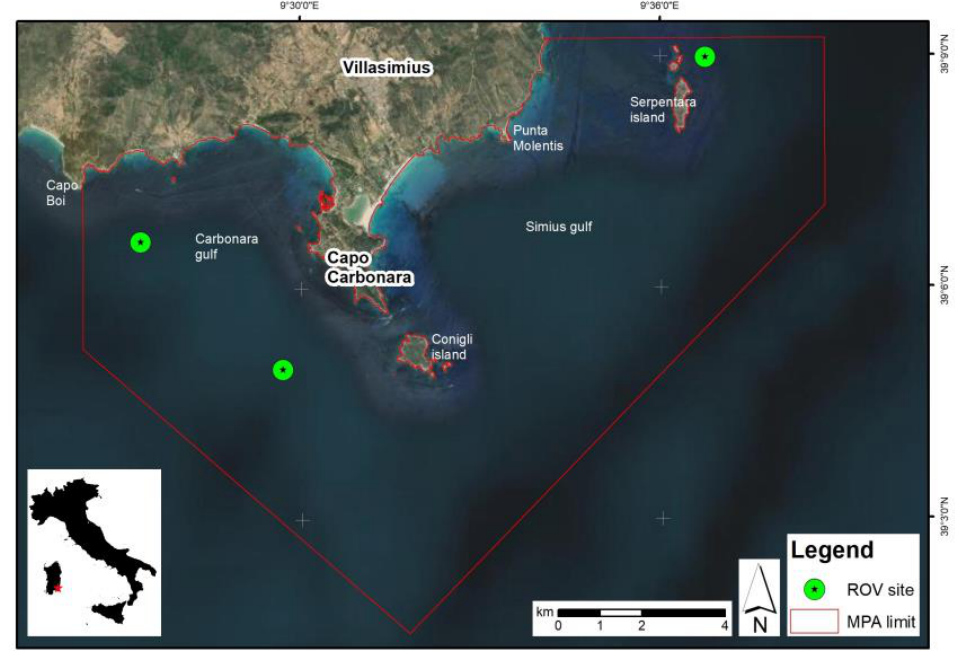
Figure 1. The Marine Protected Area “Capo Carbonara” (limit in red) is located in the southern part of Sardinia Island (Italy), with ROV sites (green dots). Service Layer Credits: Esri Digital Globe, GeoEye, EarthStar Geographic, CNES/Airbus DS, USDA, USGS, AeroGRID, IGN, and the GIS User Community.